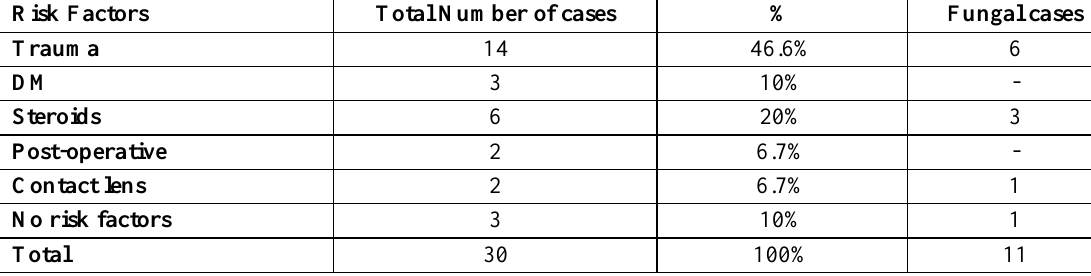
Table 2. Distribution of risk factors among the studied group. Risk